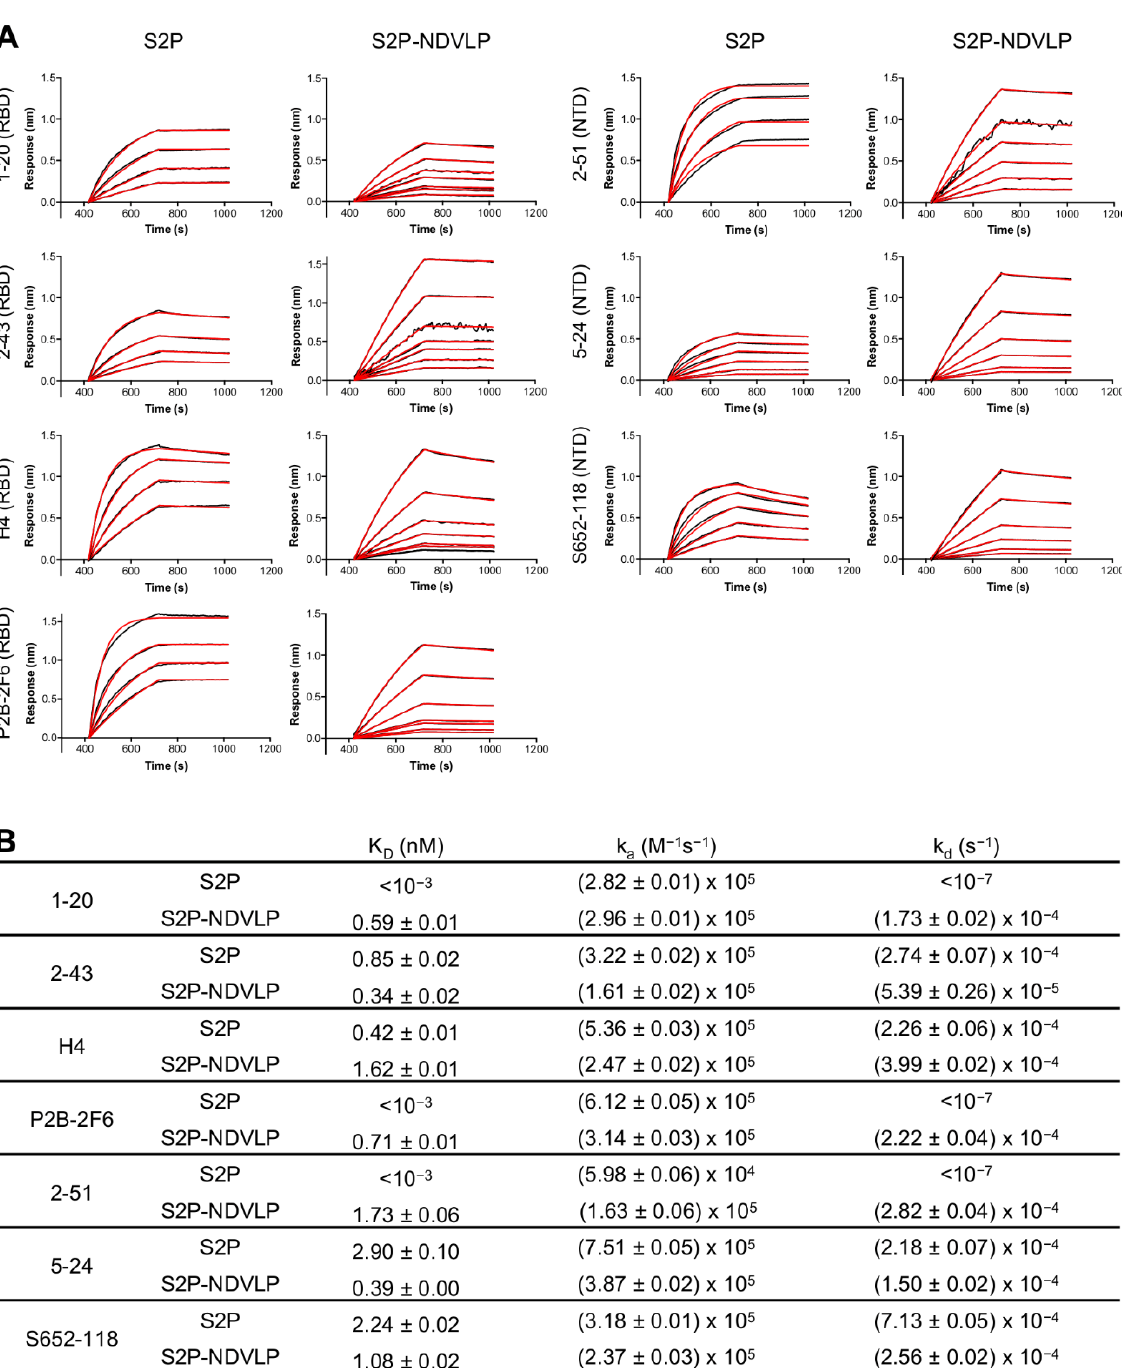
Figure 2. Characterization of S2P-NDVLP antigenicity with a panel of SARS-CoV-2 spike-specific neutralizing antibodies. ( A ) Biolayer interferometry (BLI)-binding curves. Receptor-binding domain (RBD)-specific neutralizing antibodies: 1-20, 2-43, H4, and P2B-2F6; NTD-specific neutralizing antibodies: 2-51, 5-24, and S652-118. Binding kinetics were determined by biolayer